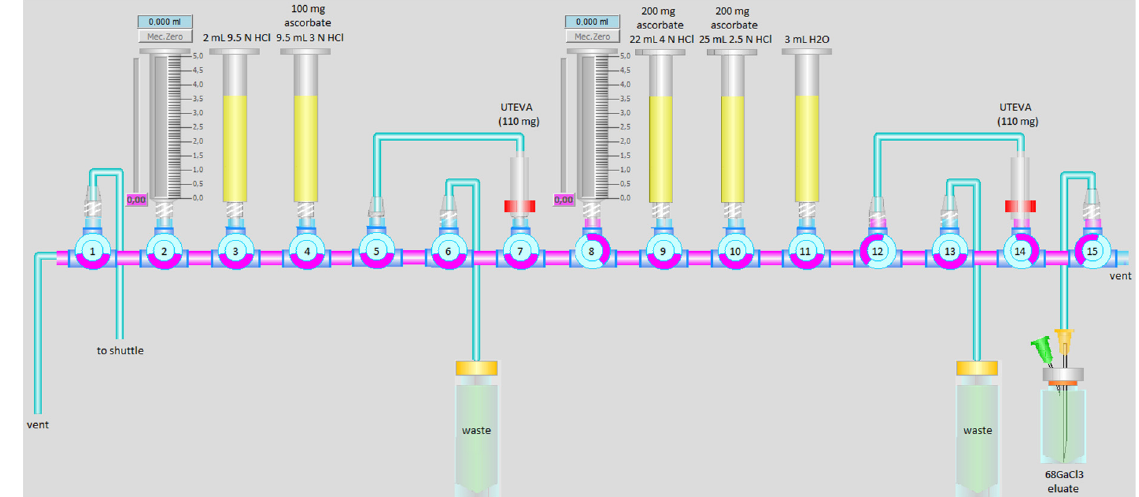
Figure 2. Schematic illustration of the automated protocol used for the separation of 68 Ga from enriched 68 Zn, using a cassette-based Taddeo PRF module (Comecer). To decrease the Fe 3+ impurity, sodium ascorbate was added in position 4 (100 mg), position 9 (200 mg), and position 10 (200 mg).